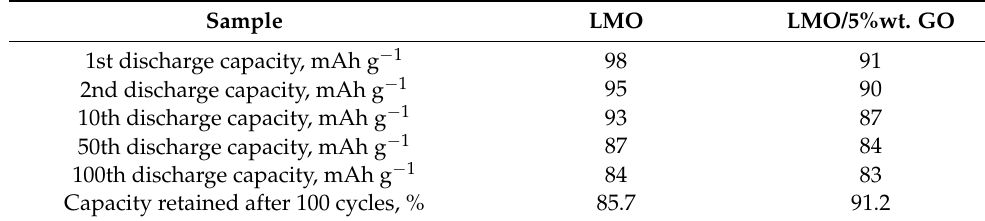
Table 3. Comparison of cyclability of LMO and LMO/5%wt. GO samples. Sample